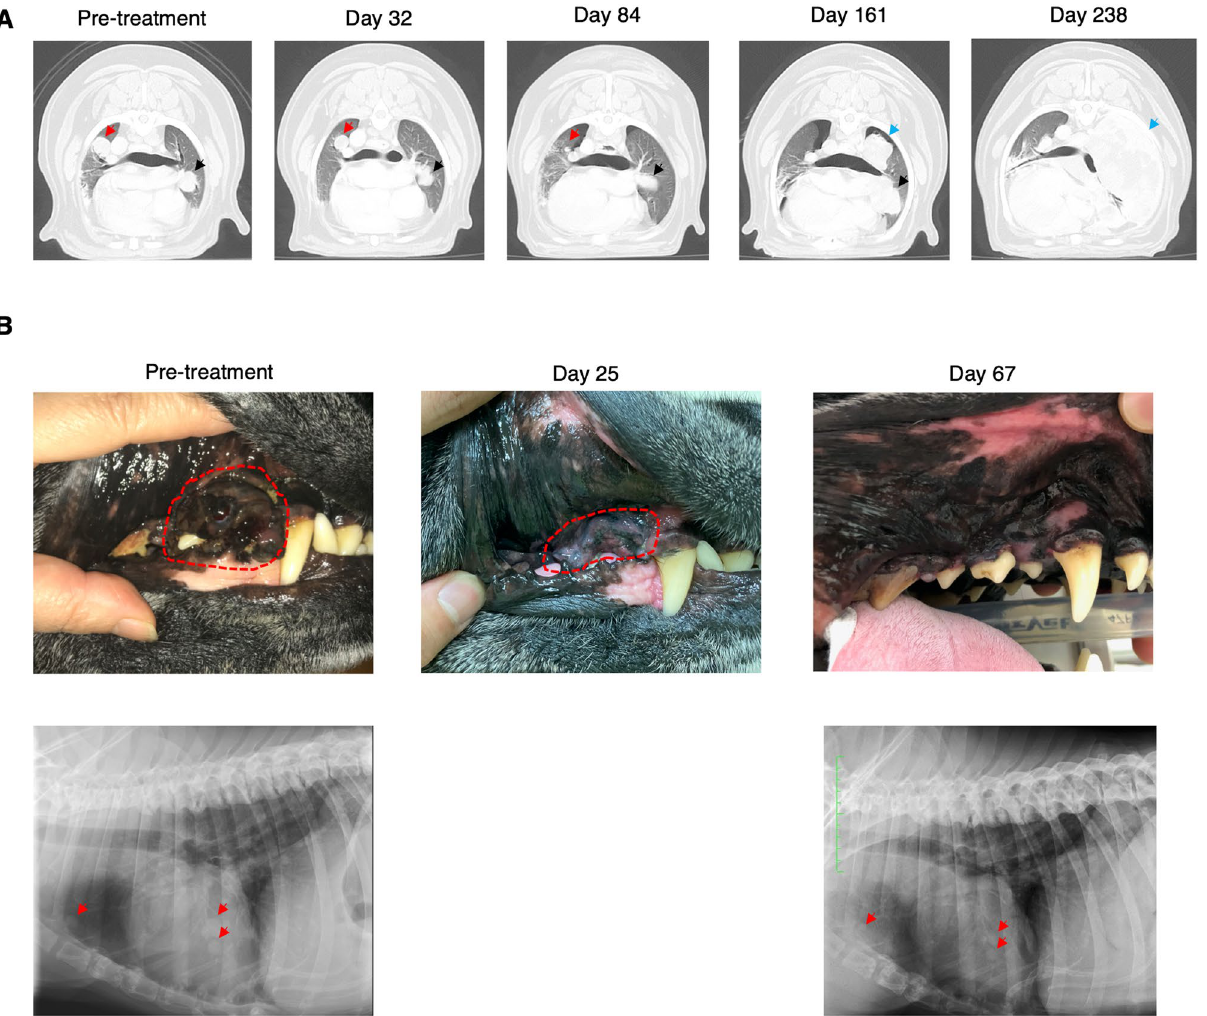
Figure 4. Antitumor response with anti-PD-1 antibody in two oral malignant melanoma cases. ( A ) Case 3: Representative CT scan images of lung metastasis of a Stage IV oral melanoma case treated with a total of 17 doses of ch-4F12-E6 administration. In pre-treatment, two masses were observed in this image (indicated as red or black arrows). After treatment with anti-PD-1 antibody, tumor masses were shrinking. On day 161, CT scanning revealed progressive disease due to new metastases (indicated by the blue arrow). ( B ) Case 30: A dog with oral melanoma involving lung metastasis (Stage IV) was treated with one cycle of ca-4F12-E6 administration. Tumor response rates in primary mass as target lesion and lung metastasis as non-target lesion were evaluated by caliper or X-ray, respectively. Oral primary mass completely responded to anti-PD-1 antibody on day 67, while tumor burden of lung metastasis (indicated as red arrows) was